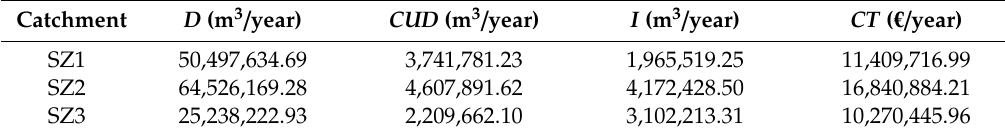
Table 6. Main water balance variables for the current state.